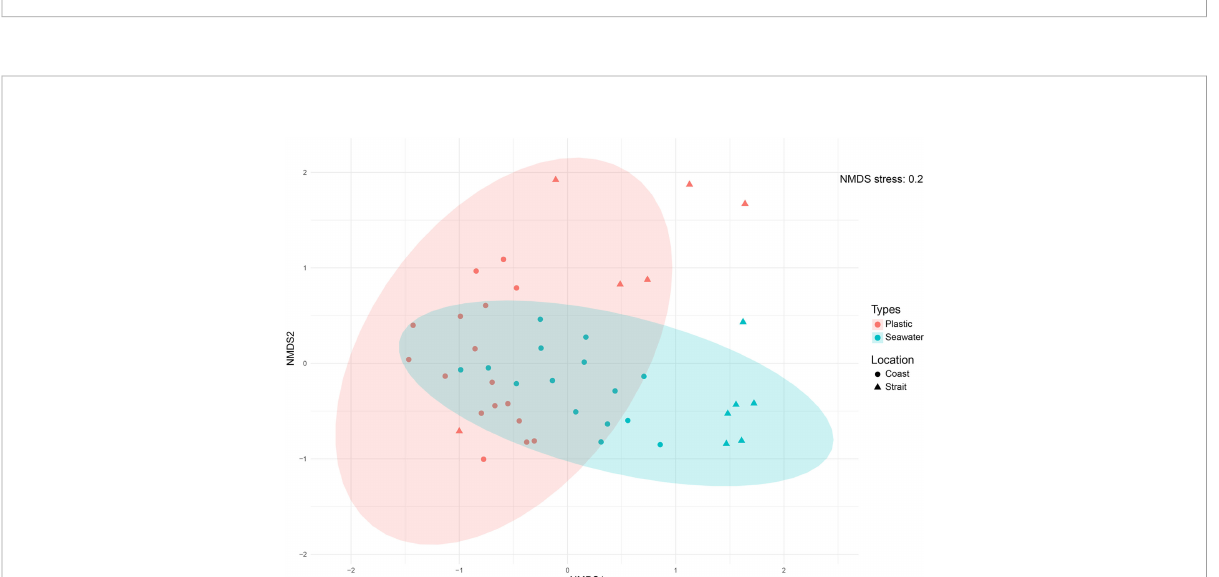
FIGURE 2 Eukaryotic operational taxonomic units (OTUs) shared between plastics and seawater samples.